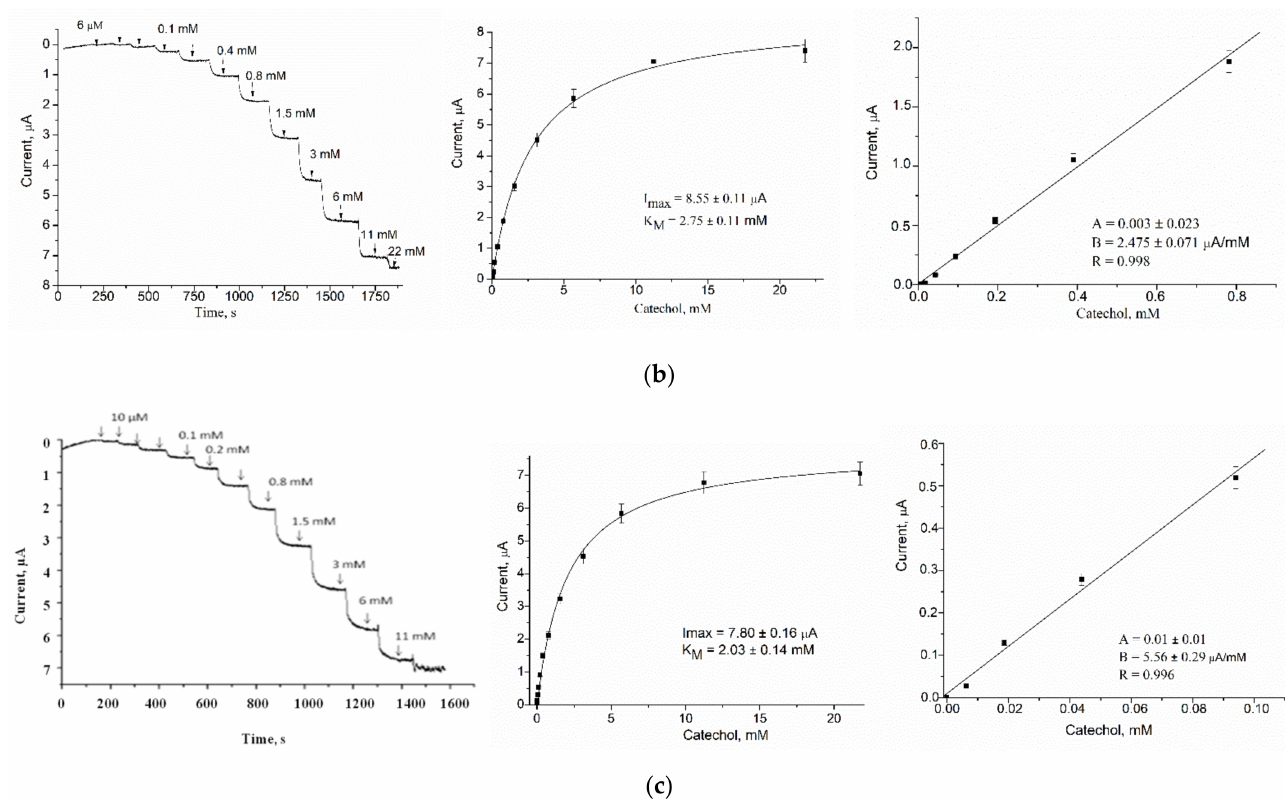
Figure A2. Chronoamperograms (left) and calibration curves for catechol determination in wide range (middle) and linear range (right) for the ABSs: laccase/GE ( a ), laccase/gFeHCF/GE ( b ), and laccase /gCuHCF/GE ( c ). Conditions: Ag/AgCl (reference electrode) in NaOAc buffer. Working potential: +230 mV.